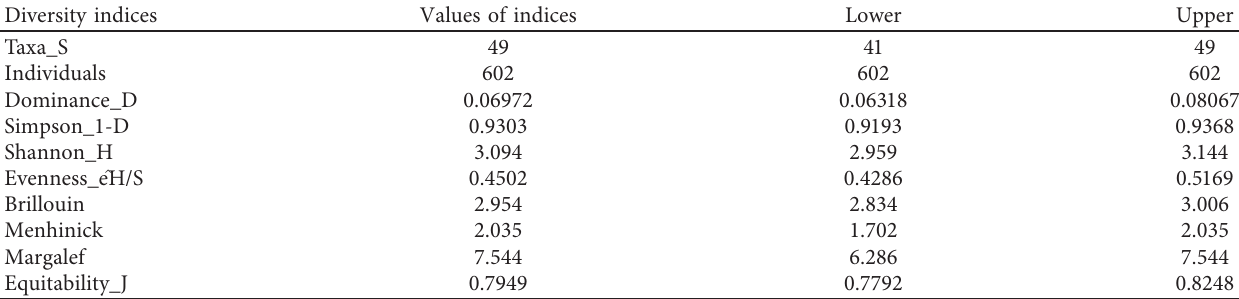
Table 2: Summary of multidiversity indices of all quantifiable parameters.